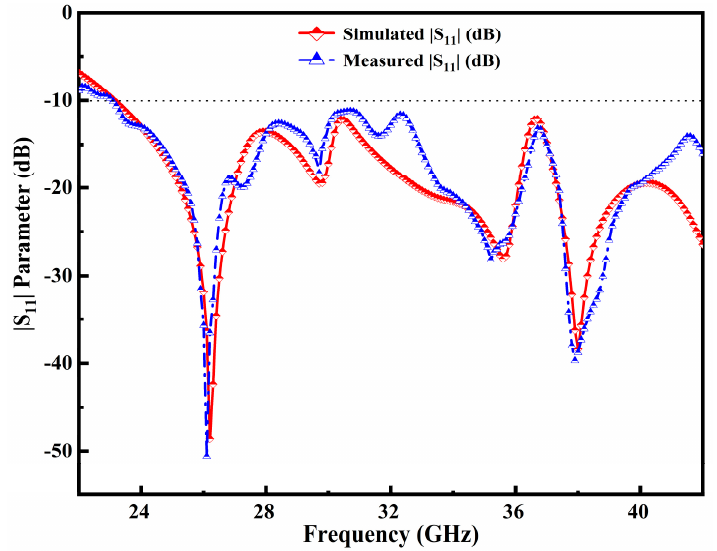
Figure 9. Simulation and measured results of |S 11 | parameter in the entire operable frequency